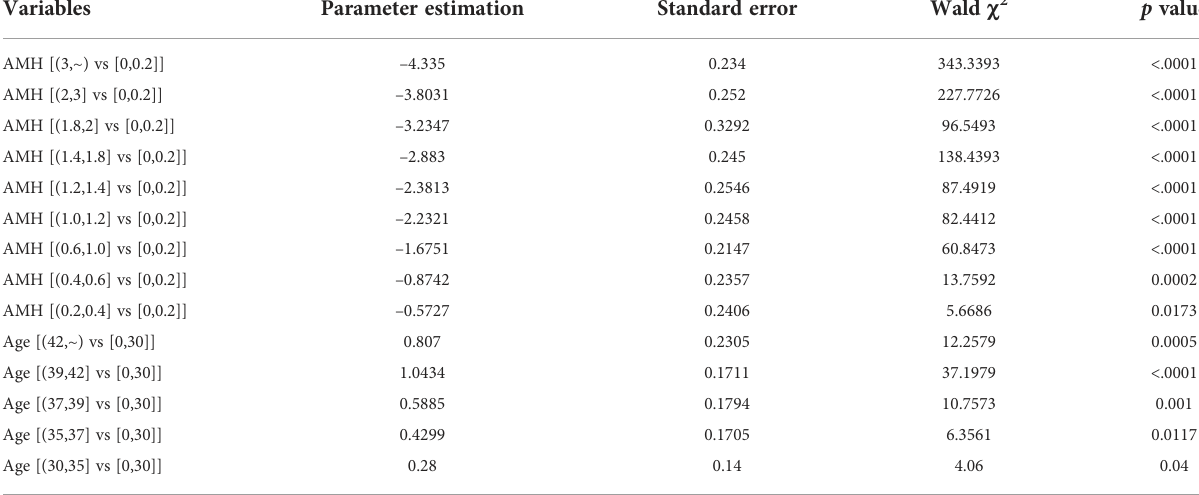
TABLE 2 The effects of each predicting variable on POR using AA